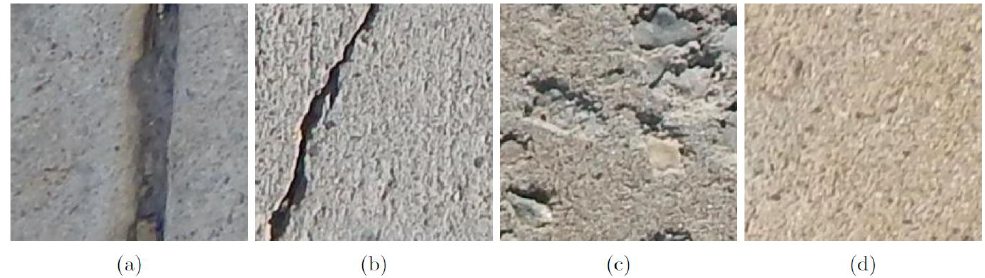
Figure 3. Classes of concrete surface defects used for GAN-based Data Augmentation: ( a ) construction joint, ( b ) cracks, ( c ) pitting, and ( d )